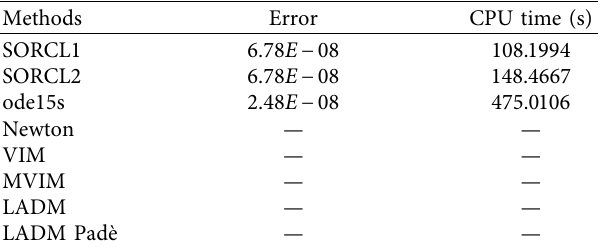
Table 7: Tolerance level at 10 − 11 (HIV model).